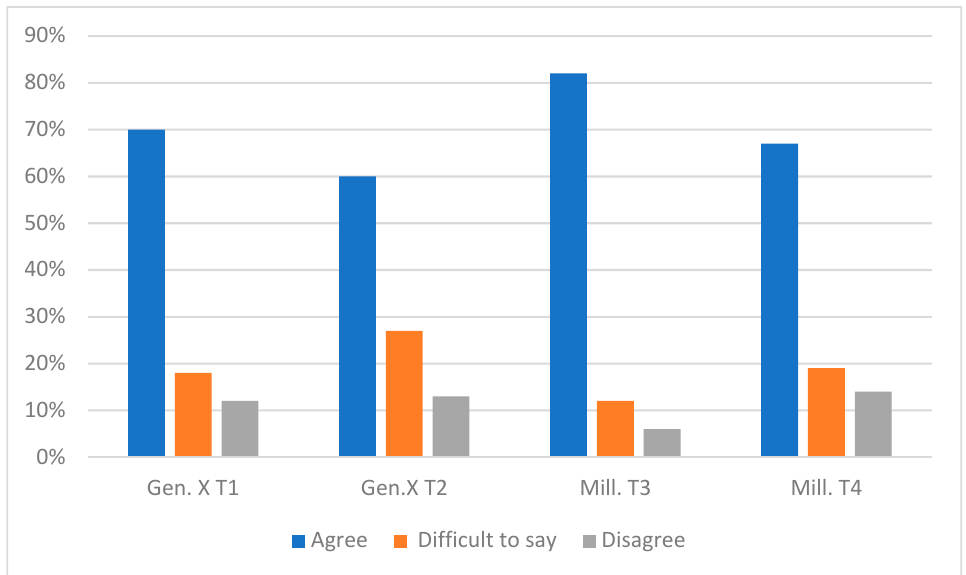
Figure 2. Our standard of living is so high that we have the means to care for the sick and other people who are badly off.